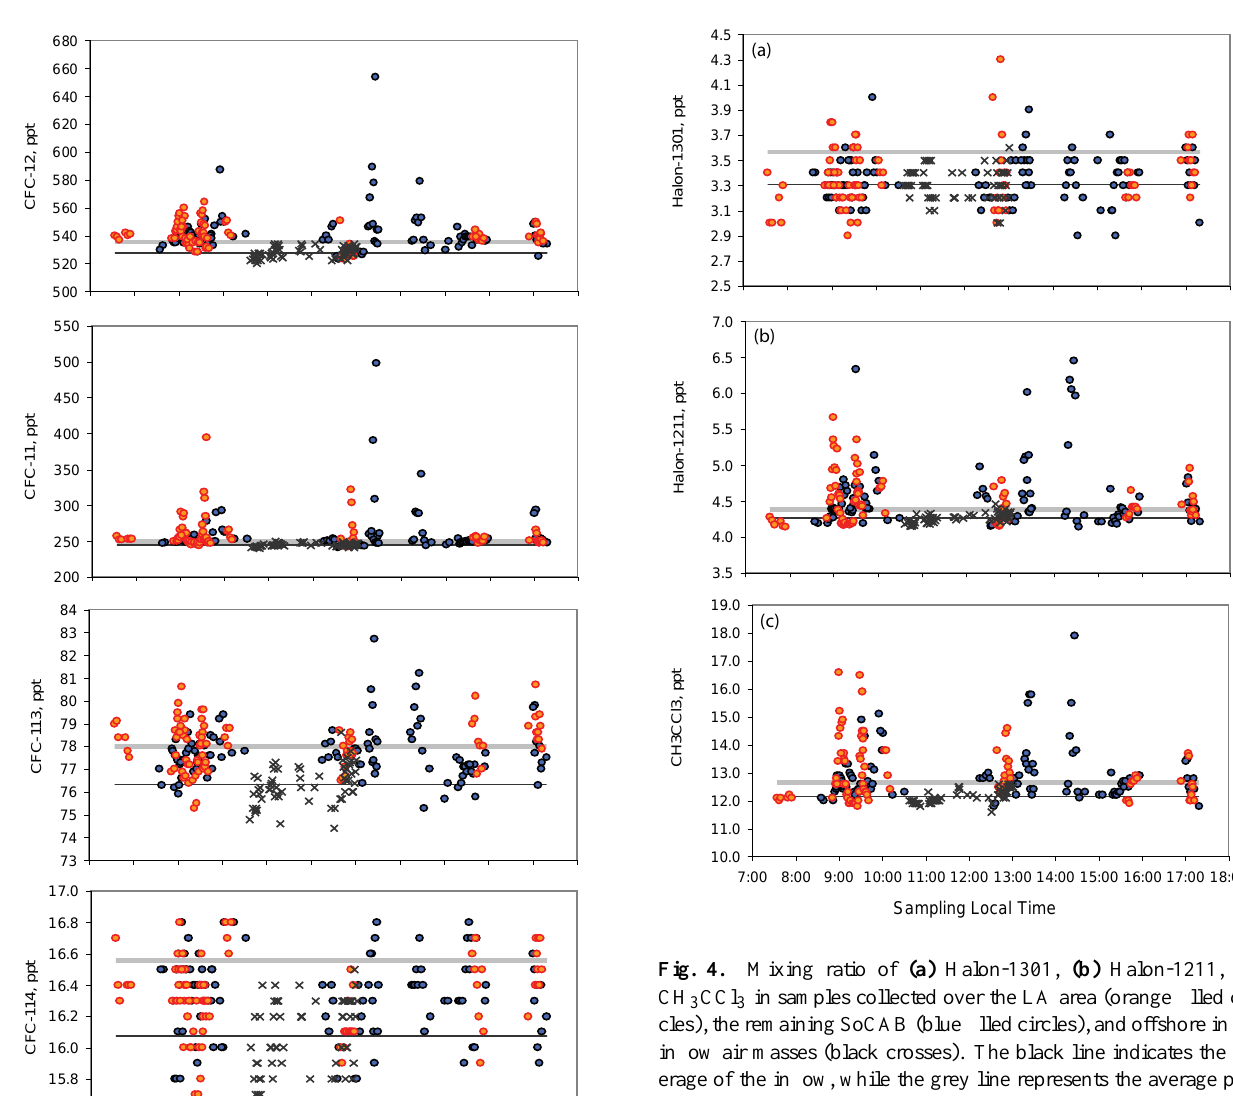
CH 3 CCl 3 in samples collected over the LA area (orange filled cir- cles), the remaining SoCAB (blue filled circles), and offshore in the inflow air masses (black crosses). The black line indicates the av- erage of the inflow, while the grey line represents the average plus two standard